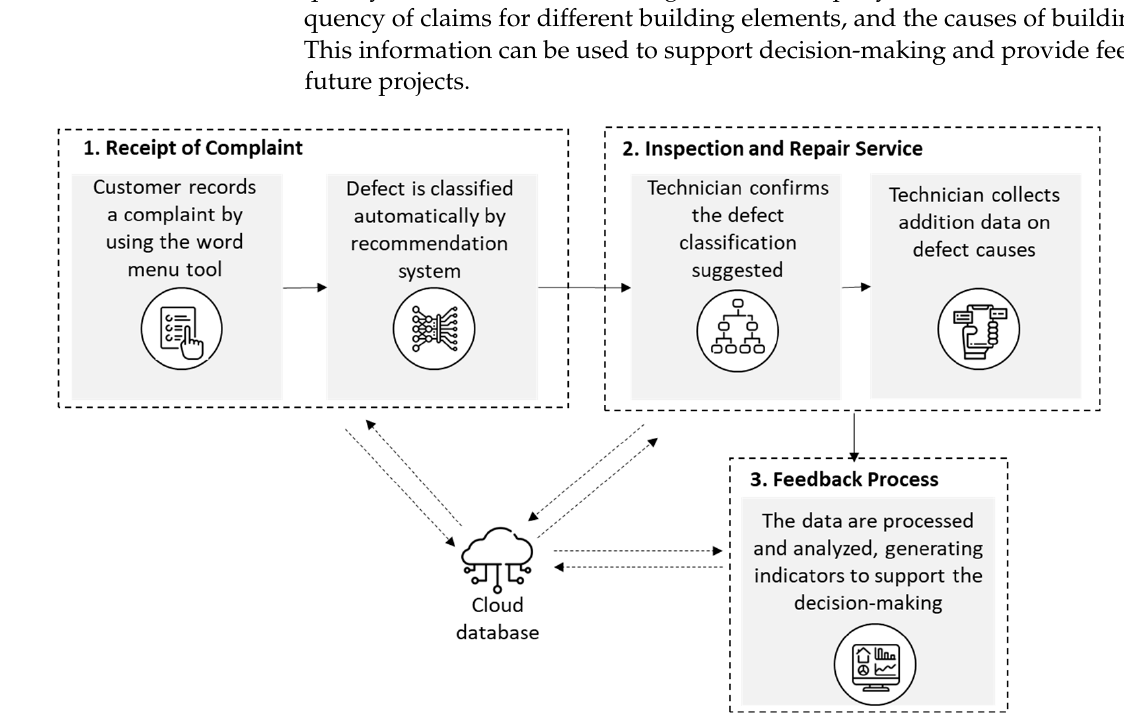
Figure 4. Proposed model.